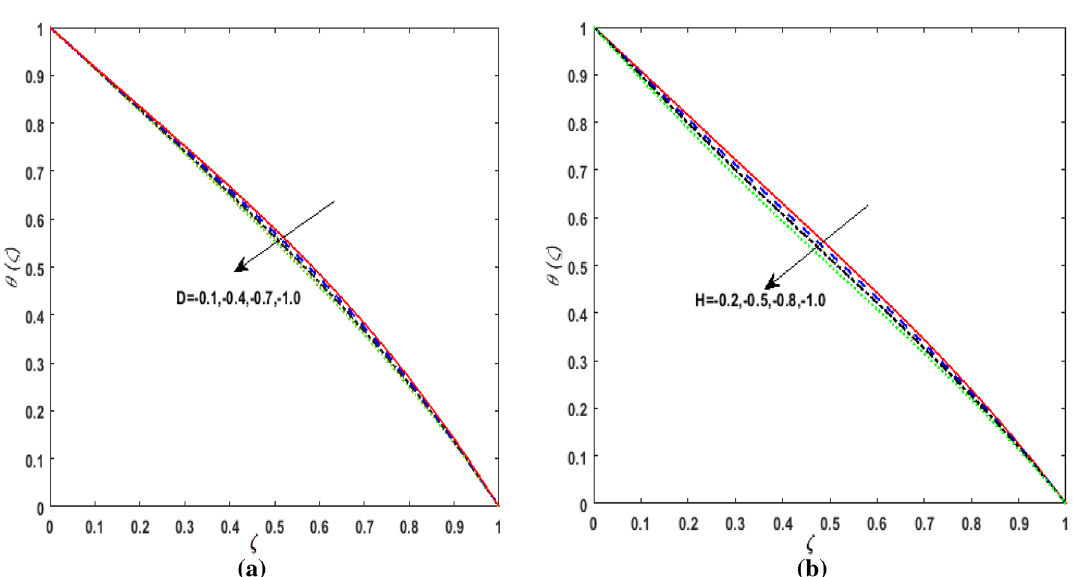
Figure 12. ( a ) Effect of temperature dependent sink parameter D < 0 on temperature θ(ζ) . ( b ) Effect of space dependent sink parameter H < 0 on temperature θ(ζ)